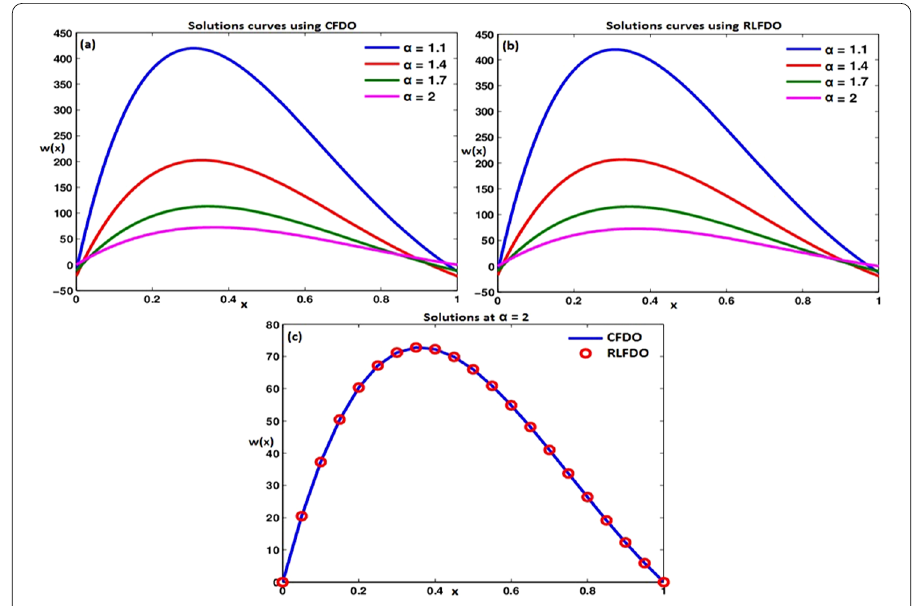
Figure 1 Steady-state solutions curves for x using ( a ) CFDO, ( b ) RLFDO and ( c ) comparison of steady-state solutions at α = 2 of Example 5.1